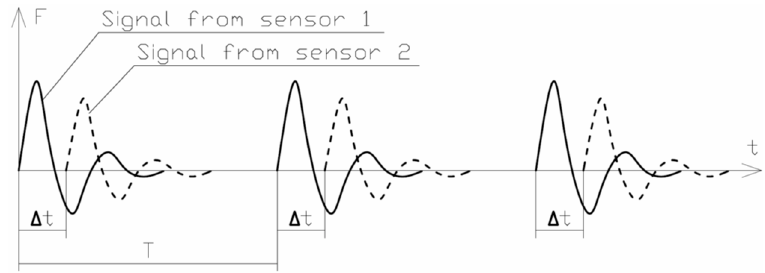
Figure 3. Achieving the shock pulse of two sensors. Next the signal from the sensors into a spectrum of amplitudes and a spectrum of phases is decomposed (Figures 4 and 5).